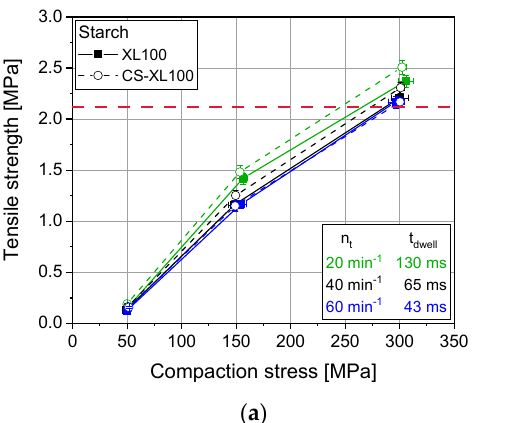
(simulated) speed, was found (Figure 3).